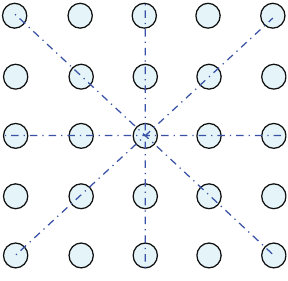
Figure 1: Noise reduction fi